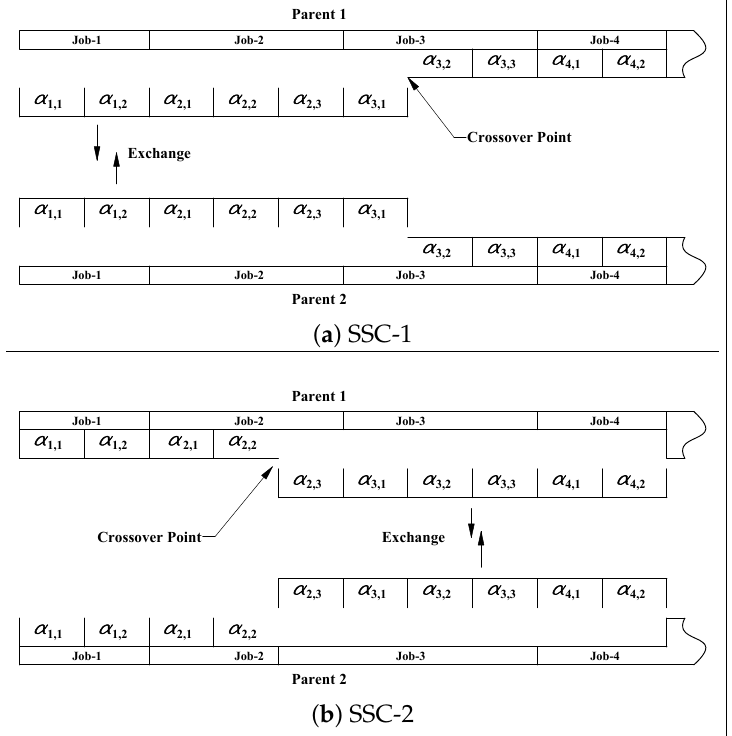
Figure 5. Illustration of the crossover operators SSC-1 and SSC-2.